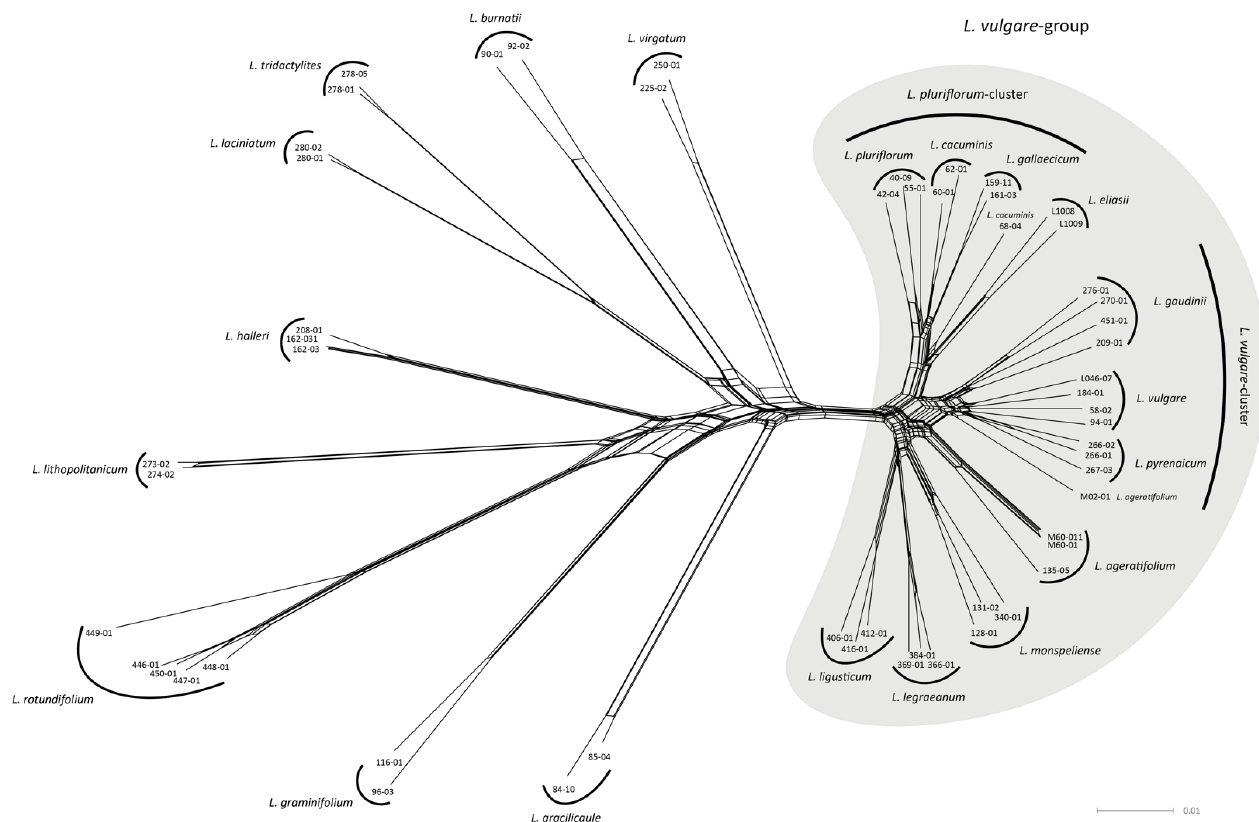
Figure 1. NeighborNet of the 20 Leucanthemum morpho-species, constructed using Kimura 2-parameter distances of the concatenated ddRAD loci from the iPyrad pseudo-reference assembly. Species membership is indicated by enclosing curves or text for single accessions. Accessions of 18 species form tight clusters, while accessions M02-01 (L. ageratifolium) and 68-04 (L. cacuminis) lie outside of the respective species clusters.